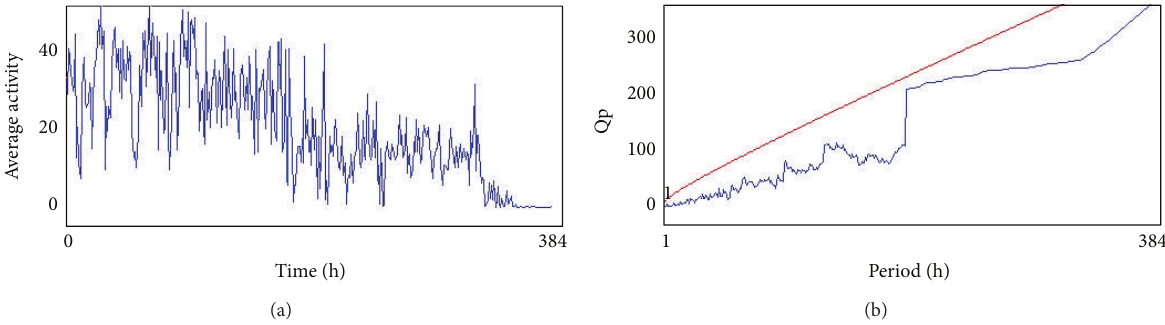
Figure 6: (a) and (b) show the average activity pattern and chi-square periodogram, respectively, for the PD flies ( 𝑁 = 20 ).